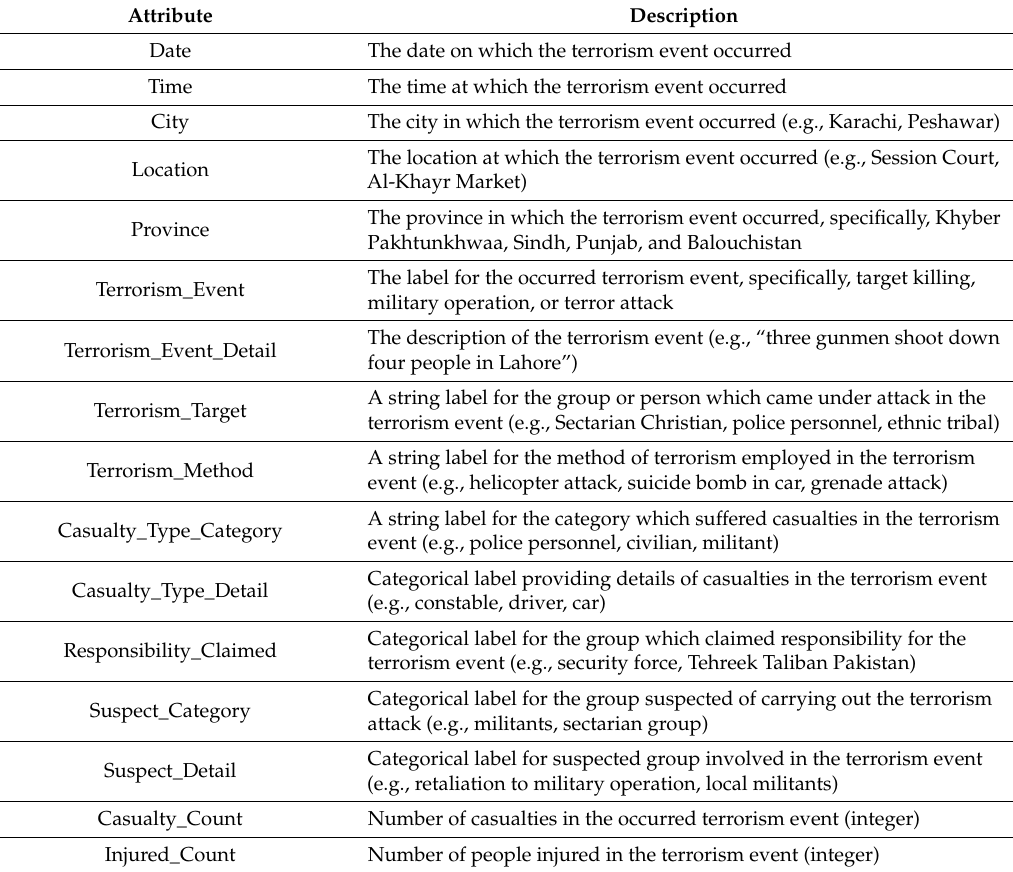
Table 1. Initial set of attributes for the terrorism data set.